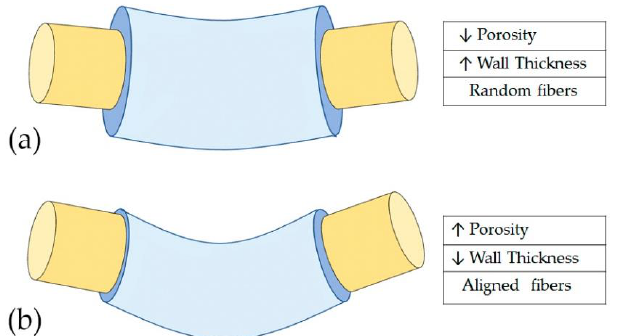
Figure 5. Schematic diagram of the bending stiffness of NGC according to the morphologies charac- teristic. ( a ) Lower porosity, higher wall thickness, and random fibers provide higher bending stiffness. ( b ) Higher porosity, lower wall thickness, and aligned electrospun fibers provide significantly lower bending stiffness.